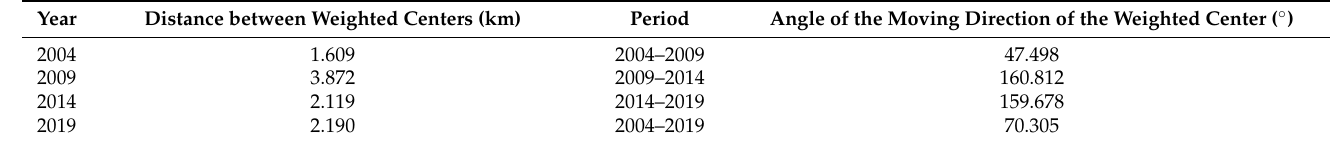
Table 5. Coupling analysis of the LST and NTL within the sixth ring road of Beijing from 2004 to 2019.